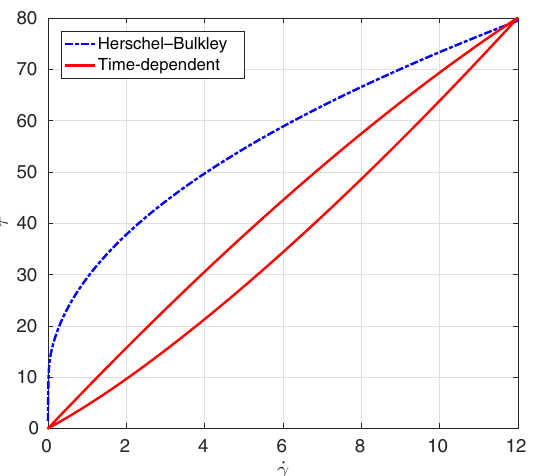
Figure 11. Subaqueous debris case 1: shear stress (Pa) and rate of strain (s − 1 ).